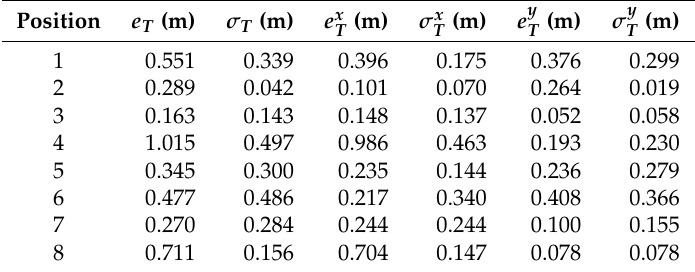
Table 9. Measured accuracy of the TSML algorithm in Scenario 4.